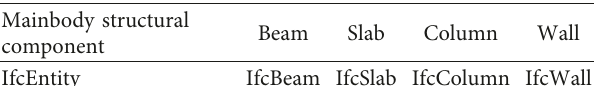
Figure 4: IFC extension process based on AttributeSet Table 4: The correspondence between structural elements and IFC